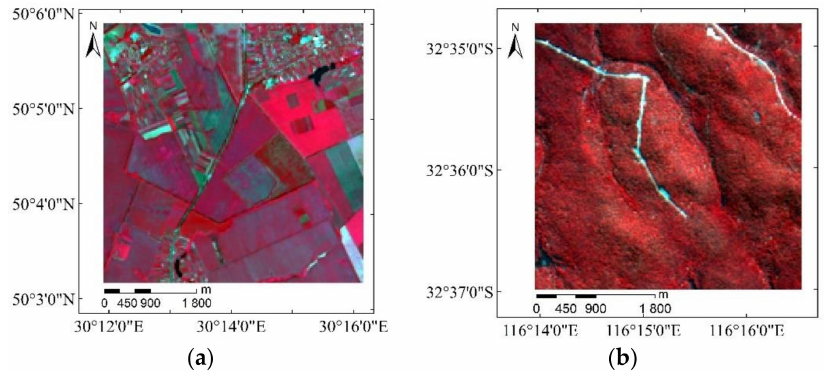
Figure 1. Location and study area of the validation site: ( a ) Pshenichne site (Landsat 8 NIR, Red and Green); ( b ) Camerons site (Satellite Pour L’observation de la Terre (SPOT) 4 NIR, Red and Green) .